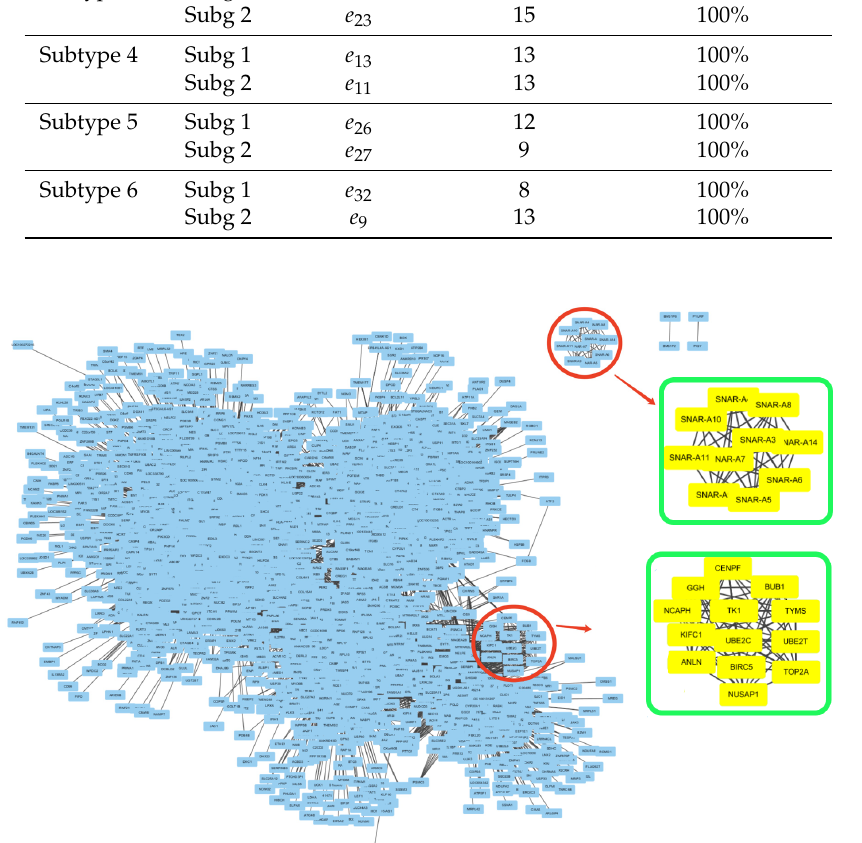
Figure 7. Two detected subgraphs in the gene co-expression network of cancer subtype 2. Two detected subgraphs are highlighted by red circles. Genes in the subgraphs are shown in the green